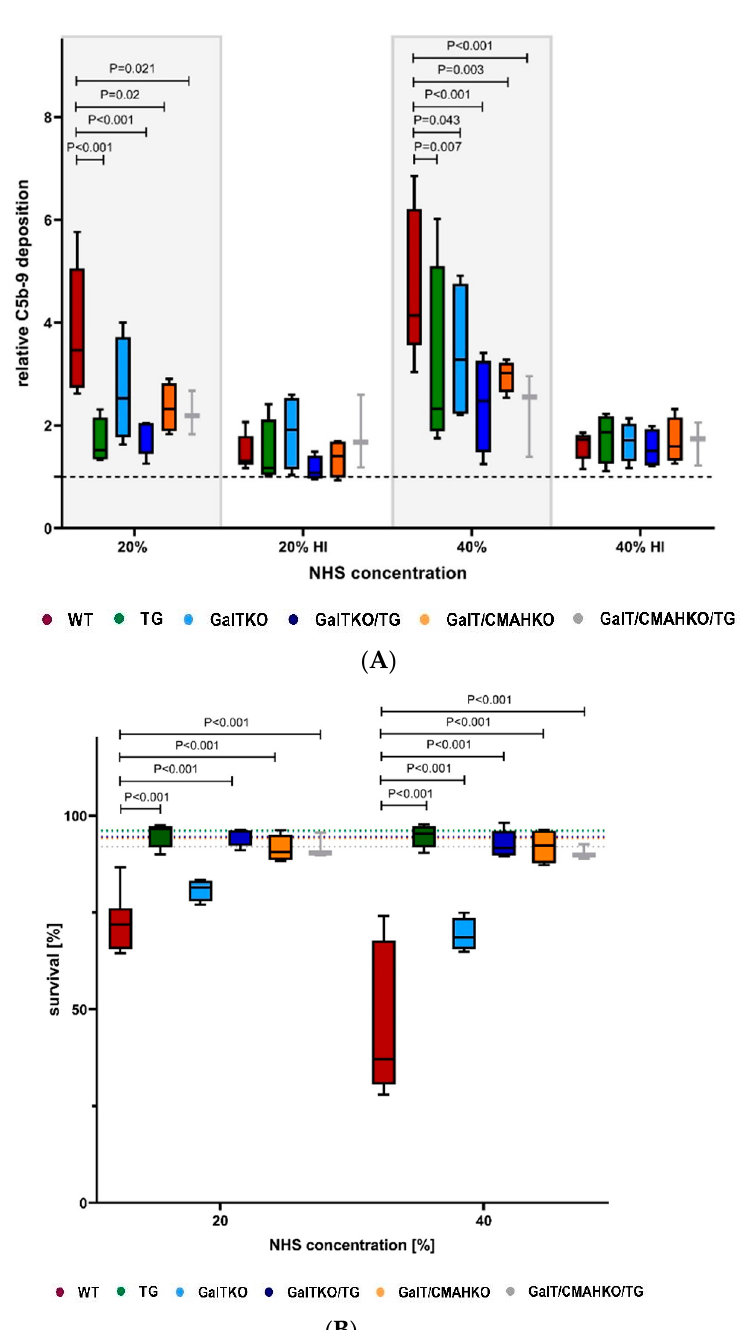
Figure 6. Xenoprotective properties of genetically modified chondrocytes on terminal pathway of complement activation. ( A ) After NHS exposure (20% or 40% and heat-inactivated), C5b-9 deposition on porcine chondrocytes were quantified by specific cell ELISA. DNA content was determined by Hoechst staining and used to normalize C5b-9 deposition. Data values are given as a ratio to unstimulated chondrocytes (dotted line), n = 3–5. ( B ) Detection of cytolysis of porcine chondrocytes after NHS exposure (20% or 40%, as well as heat-inactivated). Mean survival rates of the unstimulated variants are indicated as a dotted line in corresponding colors. Statistical analysis was done by two-way ANOVA with Dunnett’s multiple comparisons test. p -values are shown in case of significant differences compared to WT, n = 3–7.